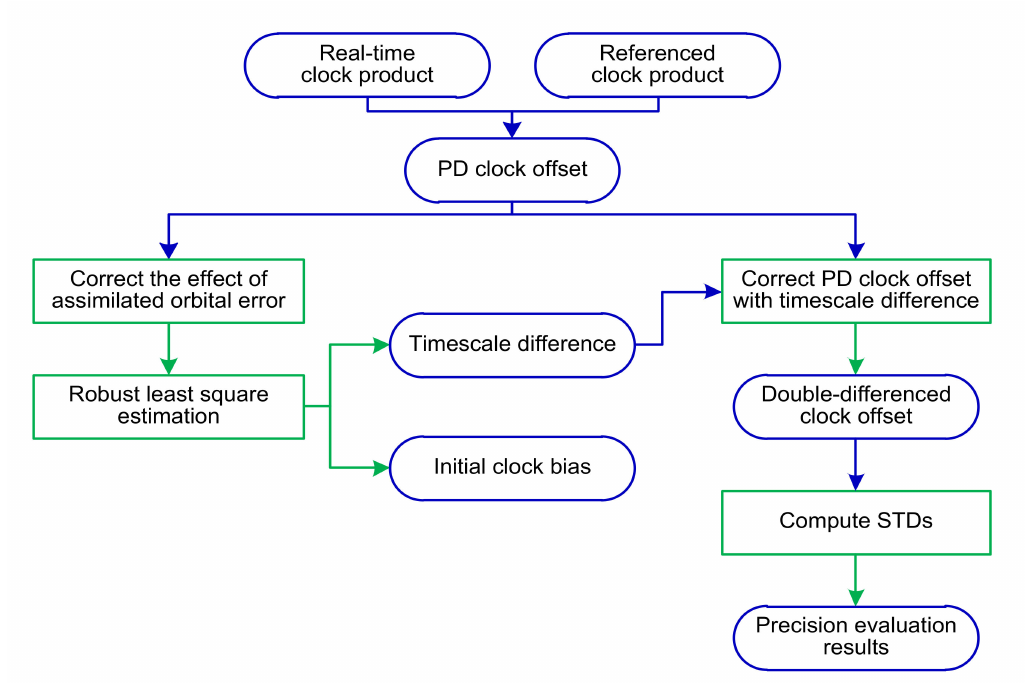
Figure 1. Flow chart of the improved multi-satellite method (IMSM) for evaluating real-time BeiDou Navigation Satellite System (BDS) clock